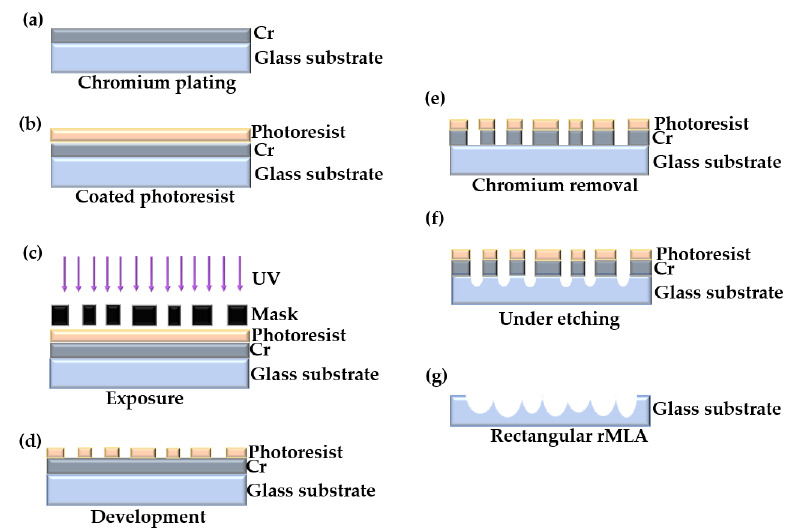
Figure 8. Fabrication schematic of rectangular rMLA: ( a ) chromium plating; ( b ) coated photoresist; ( c ) exposure; ( d ) development; ( e ) chromium removal; ( f ) under etching; and ( g ) rectangular rMLA obtained by chemical etching.